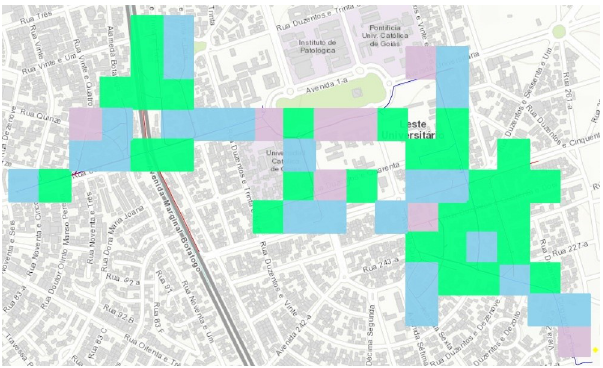
Figure 10. Result of clustering Feeder 14 to output three distinct